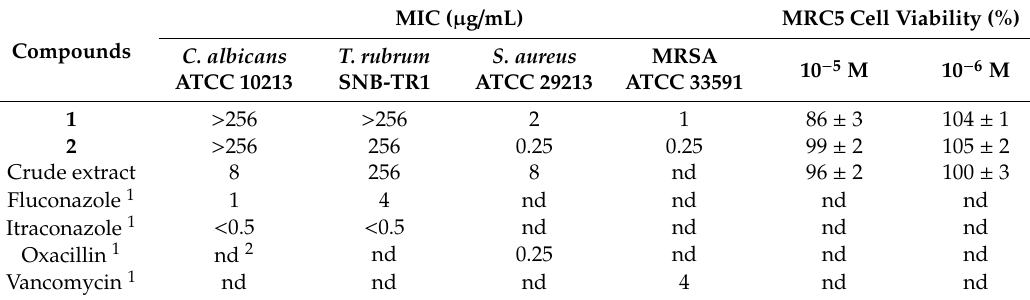
Table 2. Antimicrobial and cytotoxic results for EtOAc crude extract and isolated compounds. MIC (µg/mL) Compounds